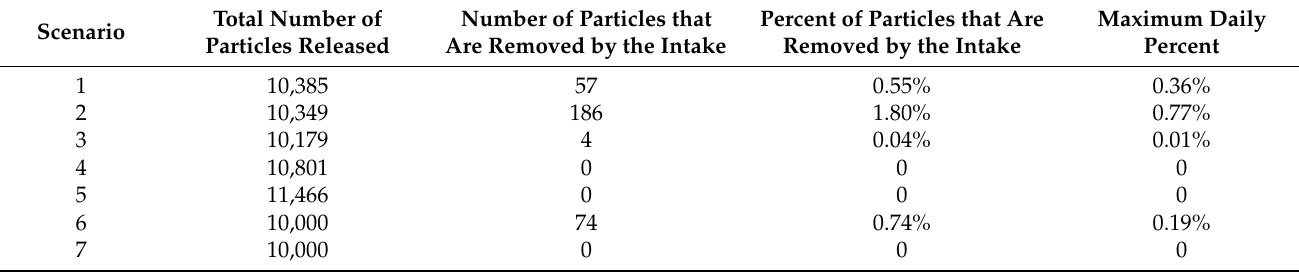
Figure 7. Daily statistics of the number of particles that are removed by the intake for scenarios 1, 2, 3, and 6. Table 3. The statistics of forward particle tracking scenarios 1–7. Kruskal–Wallis test shows that the difference between the scenarios is significant ( p -value < 10 − 6 ).